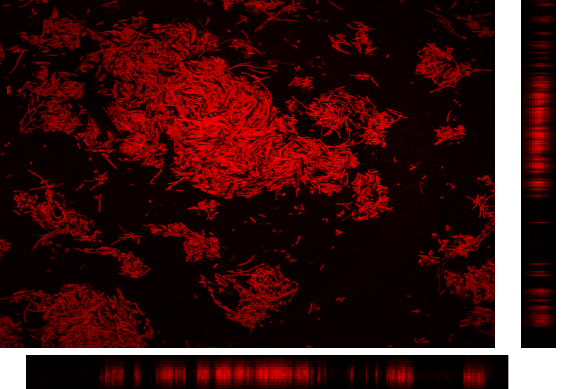
Figure 11. Orthogonal view of the 3D reconstruction of an E. coli fouling cake dyed by rhodamine 123.